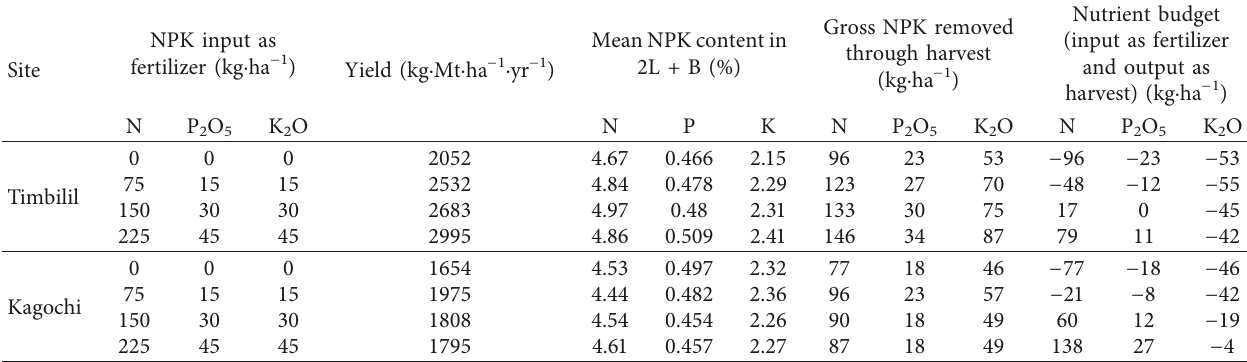
Table 1: Apparent nutrient budget of Blend A (NPKS 25: 5: 5:4 + 9Ca + 2.6Mg + trace elements) in Timbilil and Kagochi. NPK input as Site